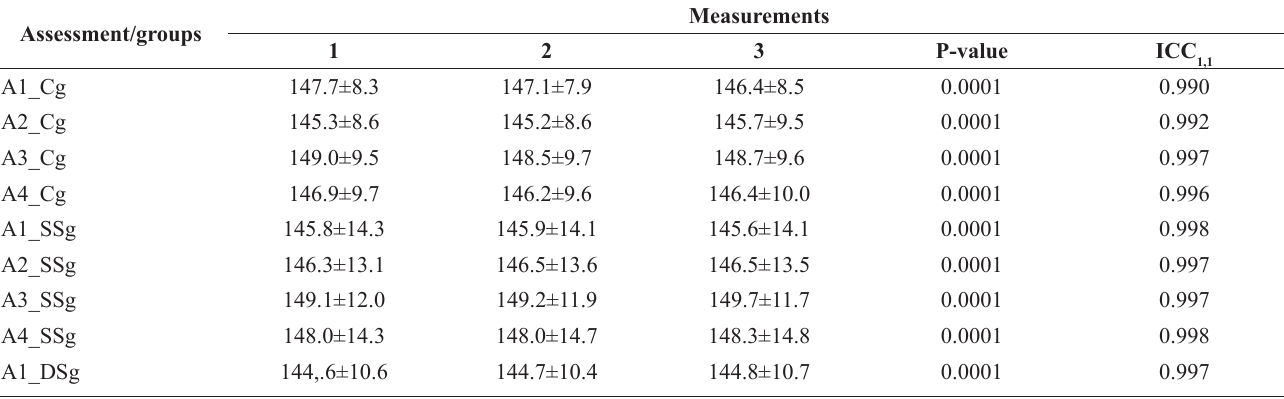
Table 2 Intra-raterintra-class correlation coefficient (ICC